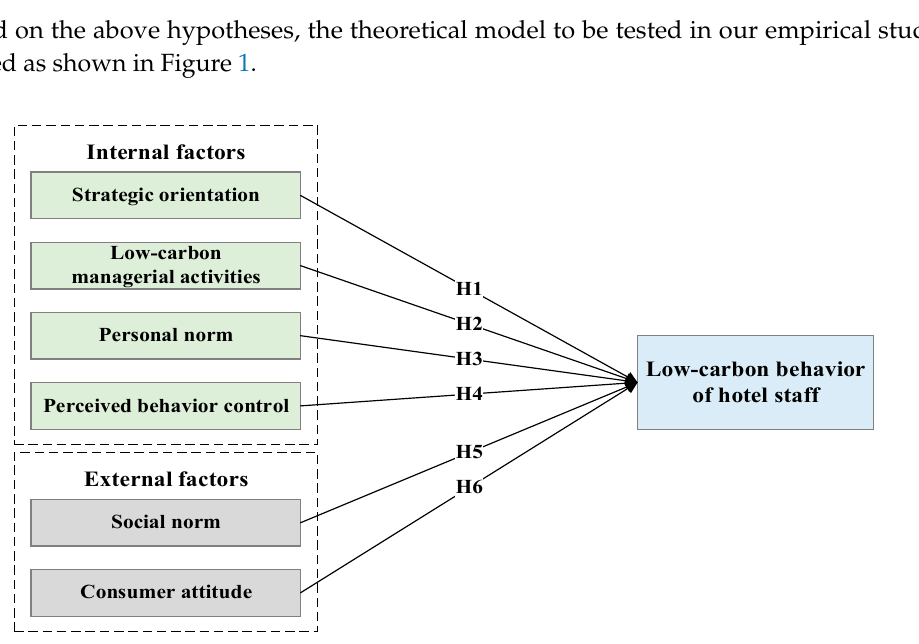
Figure 1. Theoretical model and hypotheses. (Note: H stands for hypothesis).